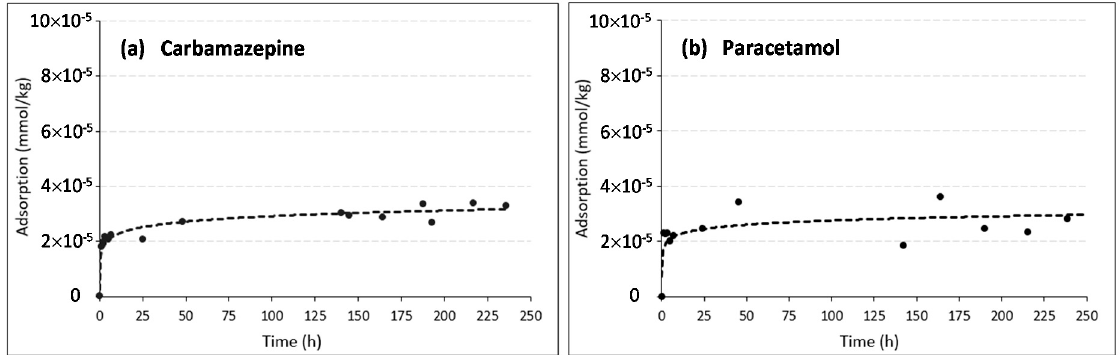
Figure 1. Sorption of carbamazepine ( a ) and paracetamol ( b ) onto saponite clay at 200 g/L.